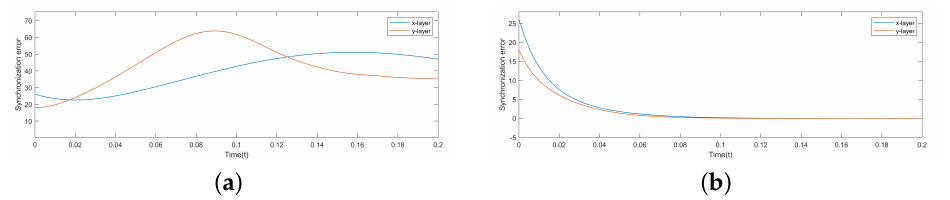
Figure 2. Intra-layer synchronization (ALS) errors. ( a ) The two − layered network without control. ( b ) The two − layered network under event − triggered control (4).